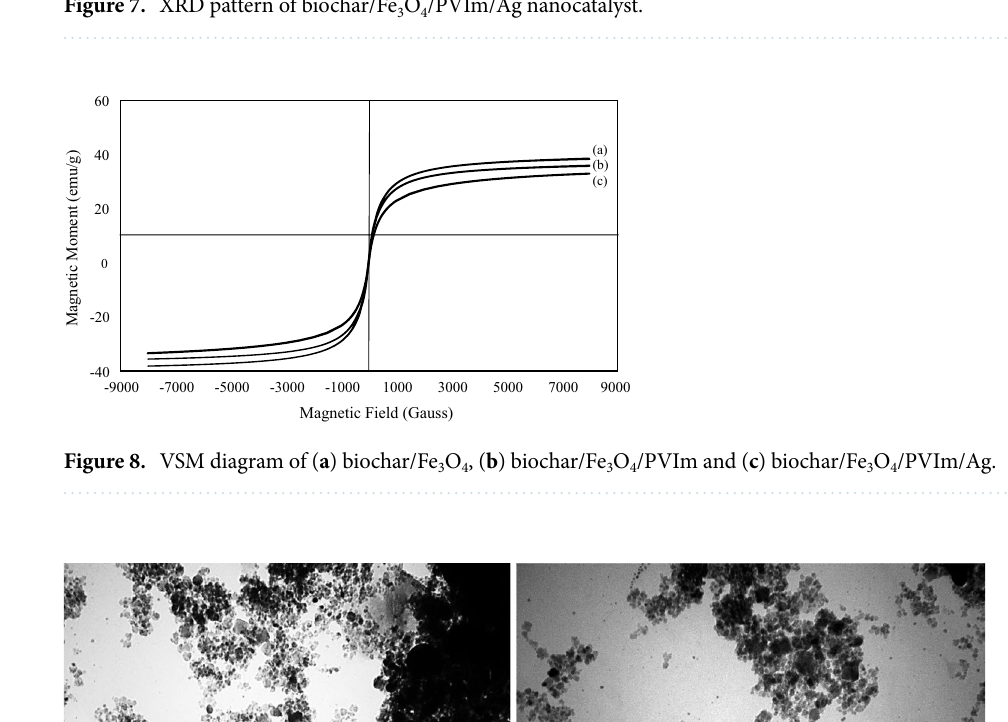
Figure 7. XRD pattern of biochar/Fe 3 O 4 /PVIm/Ag nanocatalyst.